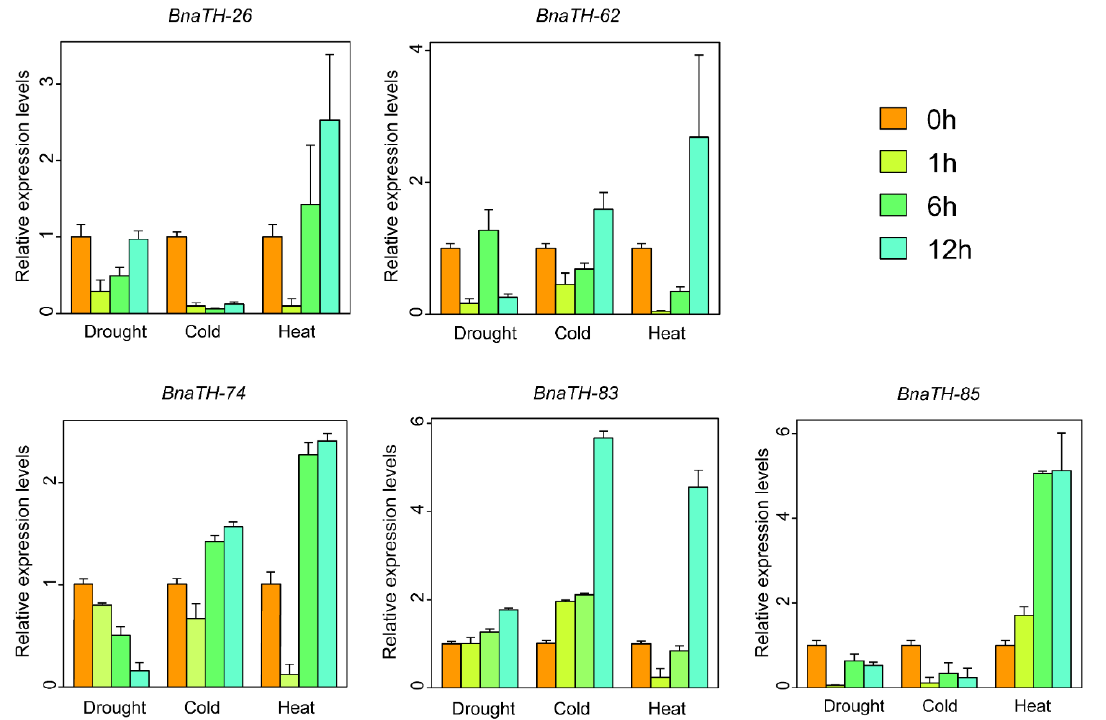
Figure 10. Expression profiles of five random selected TH genes in response to drought, cold, and heat treatments. Leaves were collected at 0 h, 1 h, 6 h, and 12 h after different treatments. Data were normalized to the BnACTIN gene. Vertical bars indicate standard d eviations.